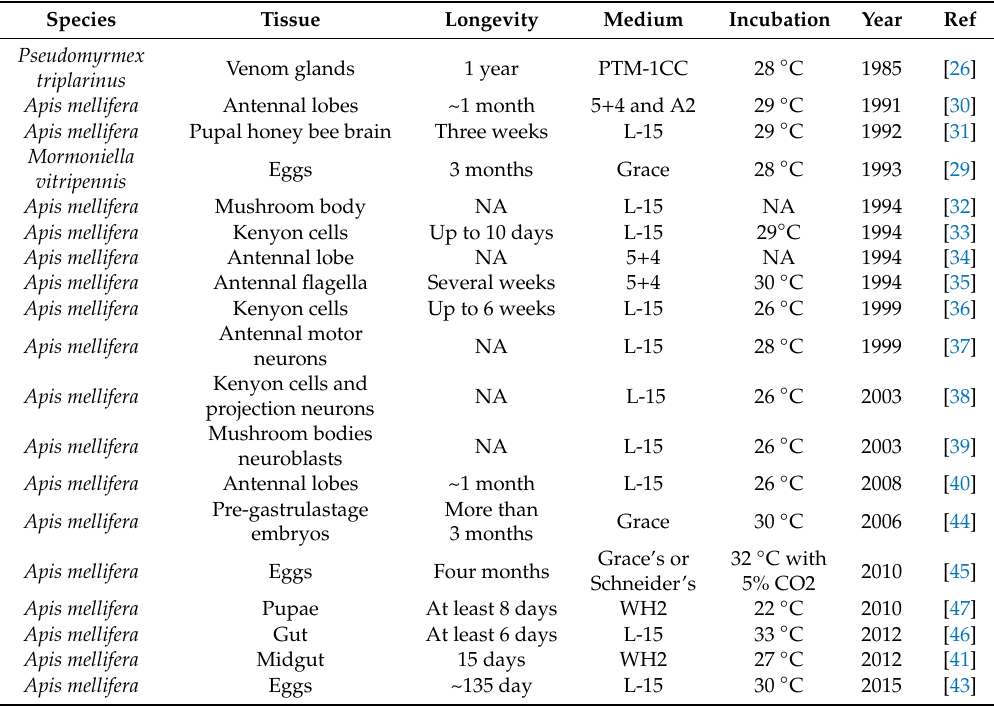
Table 1. Primary cell cultures from hymenopteran species.